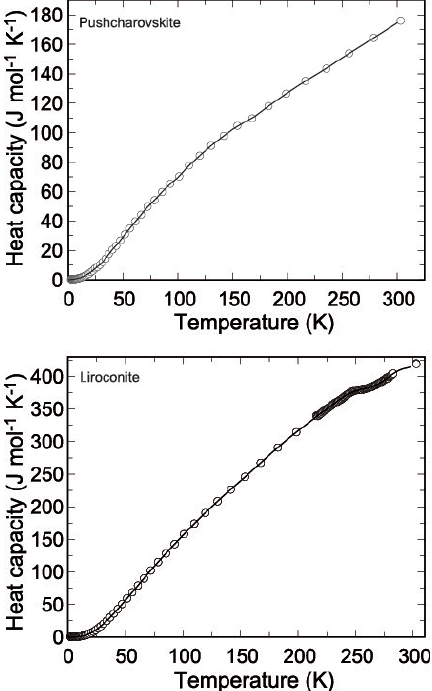
Figure 4. Low-temperature heat capacity of pushcharovskite and liroconite. Circles show the measured data, and the curves are the polynomials used for